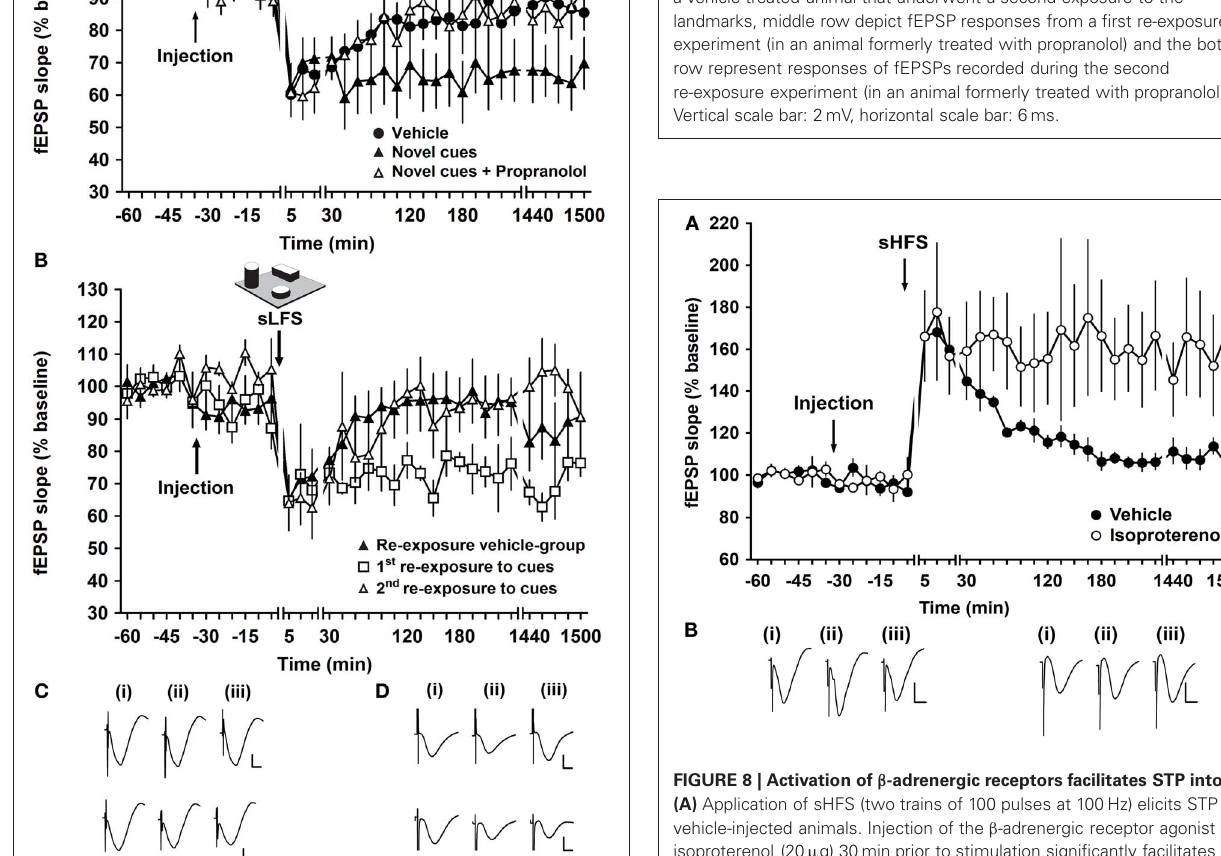
FIGURE 8 | Activation of β -adrenergic receptors facilitates STP into LTP. (A) Application of sHFS (two trains of 100 pulses at 100Hz) elicits STP in vehicle-injected animals. Injection of the β -adrenergic receptor agonist isoproterenol (20 μ g) 30min prior to stimulation significantly facilitates STP into LTP. Line breaks indicate change of time-scale. (B) Analog traces recorded from an animal during the control experiment (i) 5min pre-sHFS, (ii) 5min post-sHFS, and (iii) 24h post-sHFS. Vertical scale bar: 2mV, horizontal scale bar: 6ms. FIGURE 7 | Learning-facilitated LTD depends on the activation of β -adrenergic receptors at mossy fiber-CA3 synapses. (A) Application of 1Hz stimulation (sLFS: 600 pulses) without objects induces STD at mossy of the β -adrenergic receptor antagonist did not result in an inhi- fiber-CA3 synapses. sLFS given to vehicle-treated animals during bition of electrically induced plasticity. These findings are in line exploration of landmark cues led to LTD that lasted for at least 24h. In the with observations from other hippocampal synapses (Kemp and presence of propranolol, LTD expression is impaired during exploration of three novel cues. LTD is facilitated when the animal explores the same Manahan-Vaughan, 2008a) but are all the more striking given three cues for the second time. Changes in time scale are indicated by line the very clear mechanistic differences underlying synaptic plas- breaks . (B) Re-exposure of vehicle-treated animals to the landmark cues ticity at mf-CA3 synapses in comparison to the perforant path- (ca. seven days after first exposure) results in STD, whereas re-exposure to dentate gyrus and the Schaffer collateral-CA1 synapse the landmark cues, of the animals that were injected with propranolol (ca. one week previously, during the “novel exposure” experiment), facilitates LTD. A further (second) re-exposure of these animals to the landmark objects (ca. one week after the first re-exposure) results in STD. Changes in time scale are indicated by line breaks. (C) Analogs recorded during experiments shown in (A) , 5min pre-sLFS (i), 5min post-sLFS (ii) and 24h post-sLFS (iii). Top row represents fEPSP responses obtained during application of sLFS in vehicle-treated animals in the absence of novel landmarks, middle row represent responses elicited in animals that (Continued)